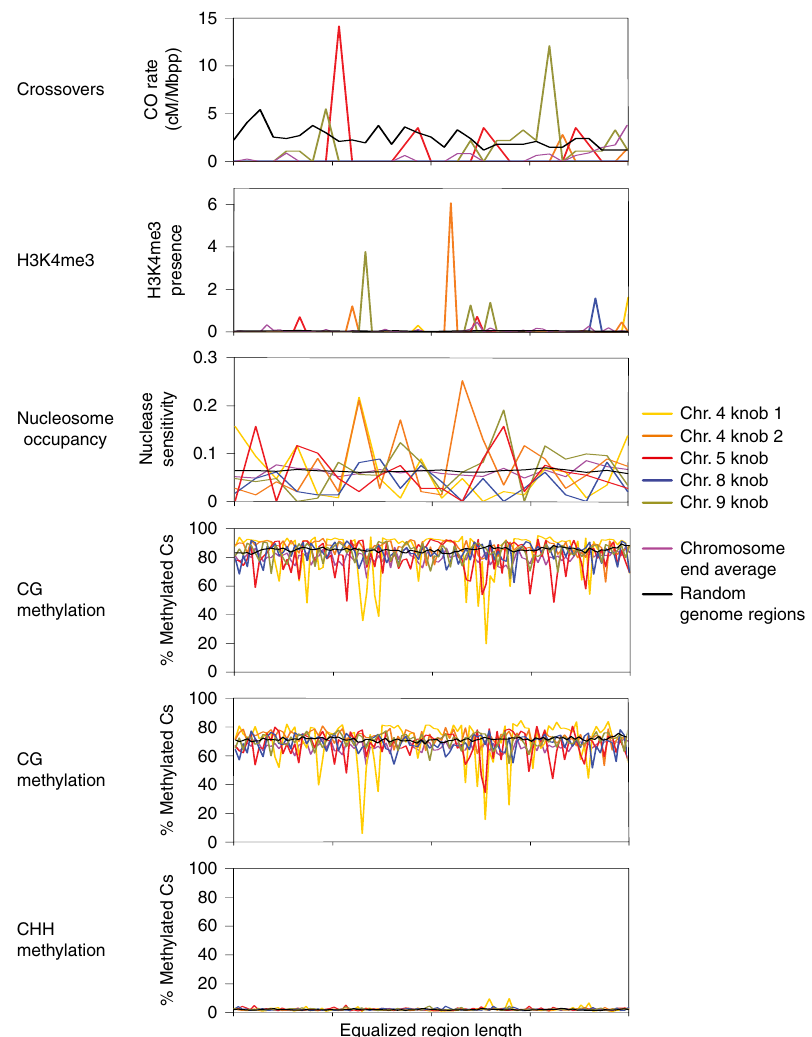
Fig. 4 Recombination and chromatin features at knobs and chromosome ends. All regions were equalized to the same size and divided into 100 bins for analysis, except nucleosome occupancy, which was divided into 30 bins to improve readability of the graph. The fi ve knobs mapped in B73 are shown. The sixth knob present in B73 and the single knob present in Mo17 are not anchored to the maize genome scaffold and were not